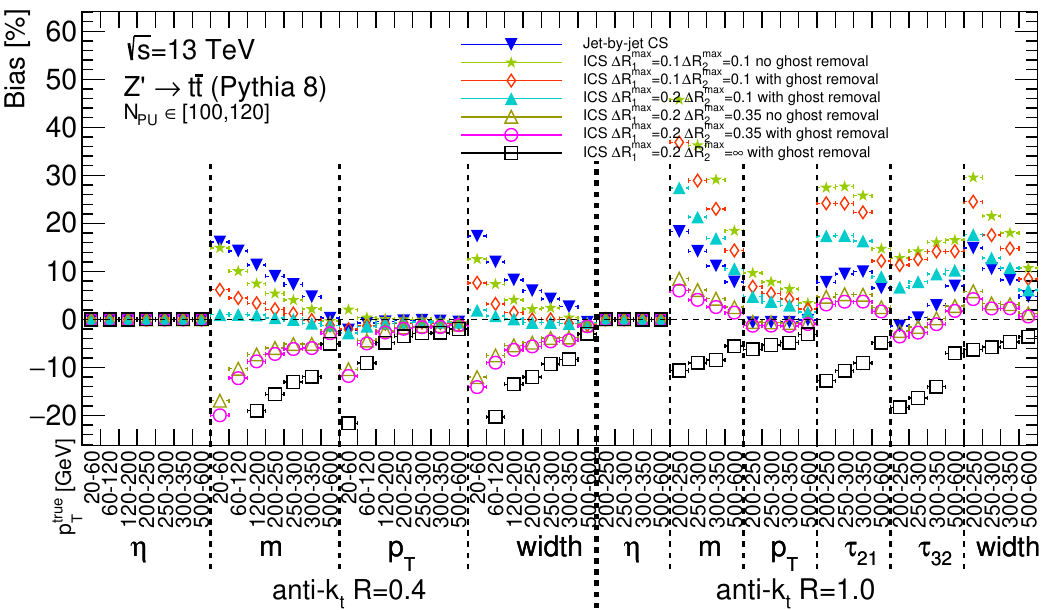
Figure 16. Bias for a representative set of con(cid:12)gurations for the ICS method with two iterations. The (cid:1) R max parameter for the individual iterations is varied and the ghost removal option is used or not. The other CS parameters are set to (cid:11) = 1 and A g = 0 : 0025 for each iteration.